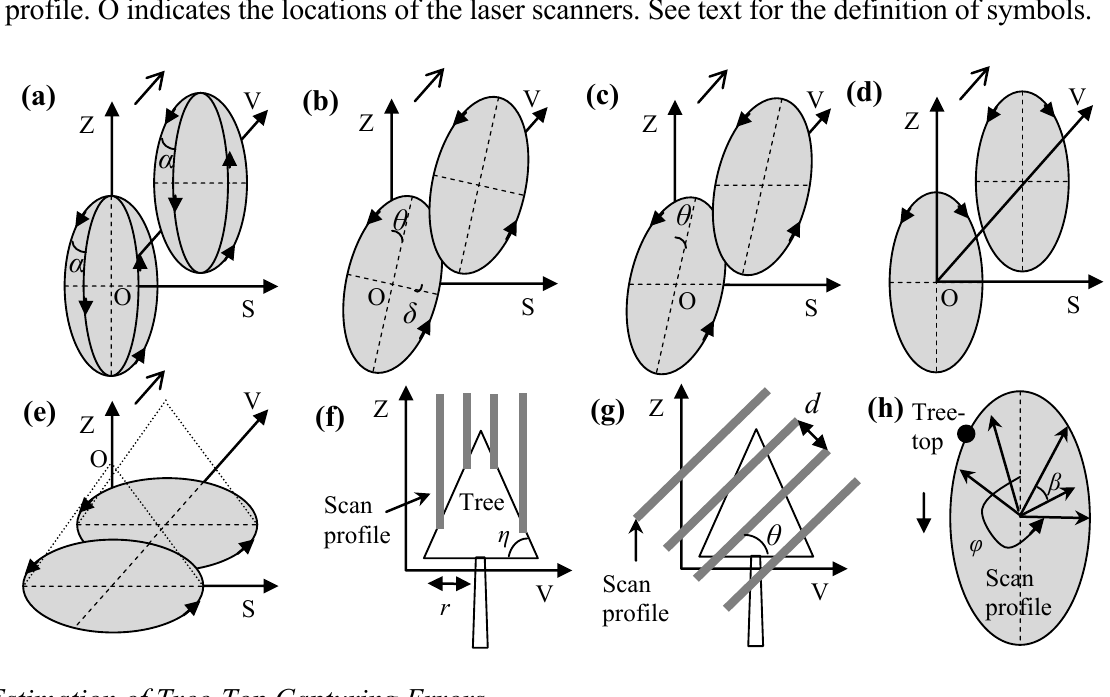
Figure 2. Schematic diagrams of laser scanning mechanisms (( a ) RoT, ( b ) RiM, ( c ) RoM, ( d ) SeMM and SeMJ, and ( e ) ToA) and schematic diagrams of tree-top scan principles (( f ) vertical scan profiles and ( g ) tilt scan profiles), wherein (f) features (a), (d) and (e), while (g) refers to (b) and (c). In addition, ( h ) shows the style of laser emissions in a scan profile. O indicates the locations of the laser scanners. See text for the definition of